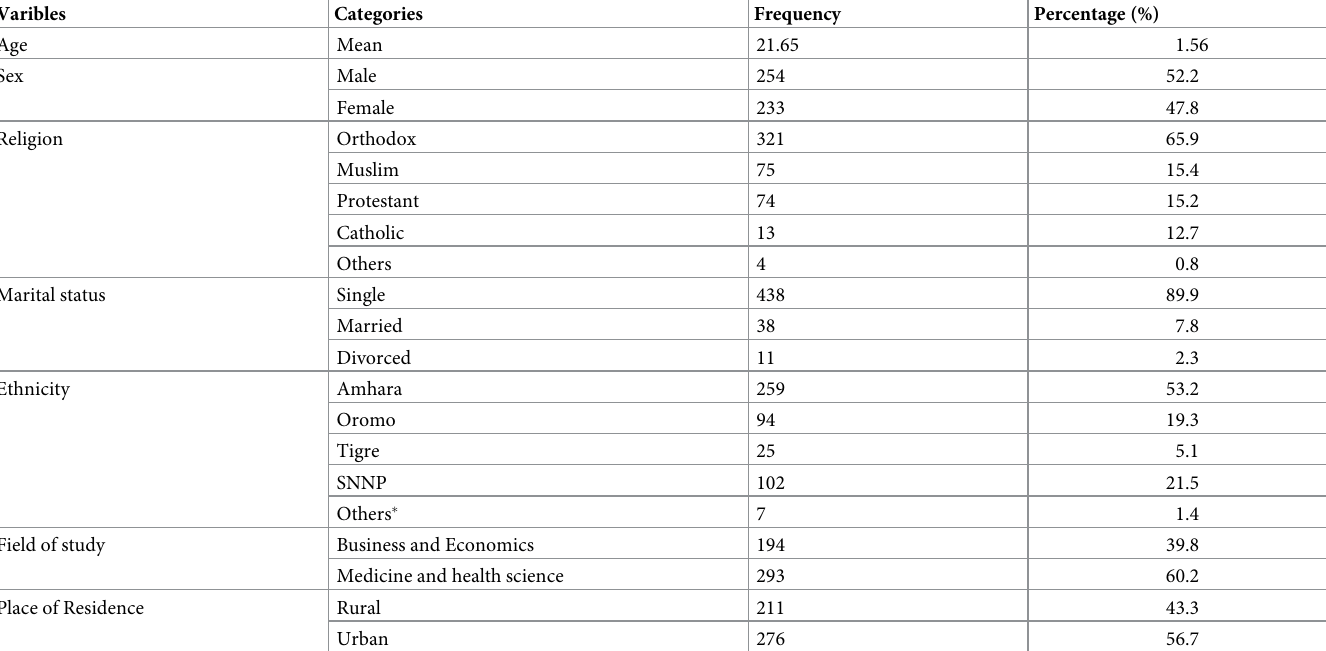
Table 1. Socio-demographic characterstics of undergraduate students of university of Gonder, northern part Ethiopia (n = 487). Varibles